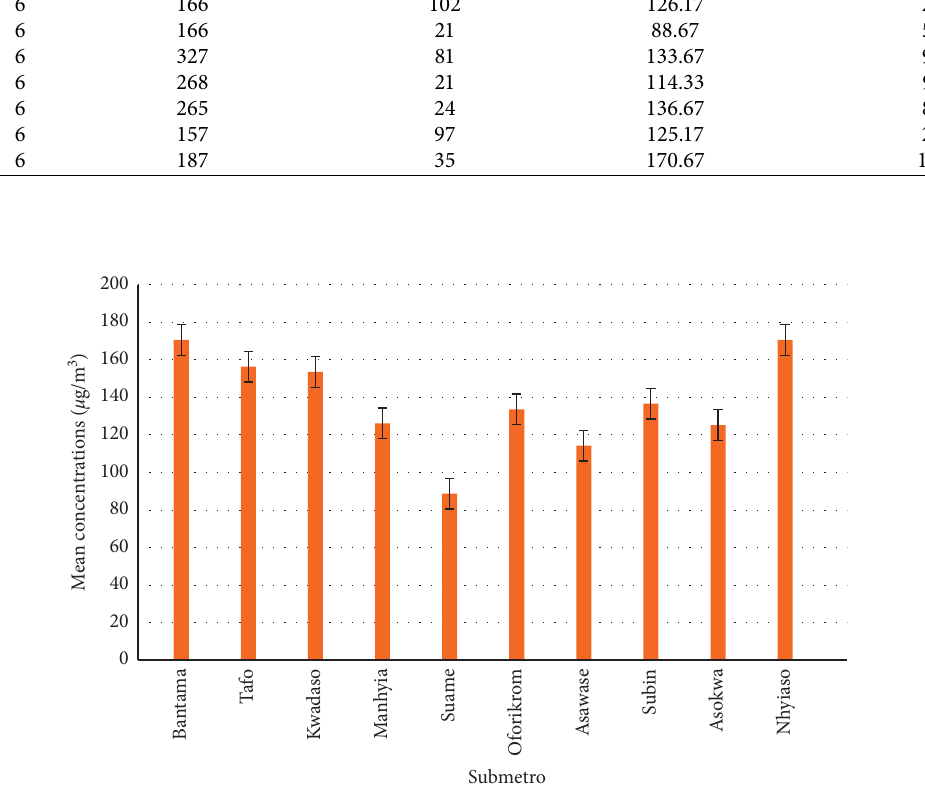
Figure 1: Graph of mean concentrations in the various